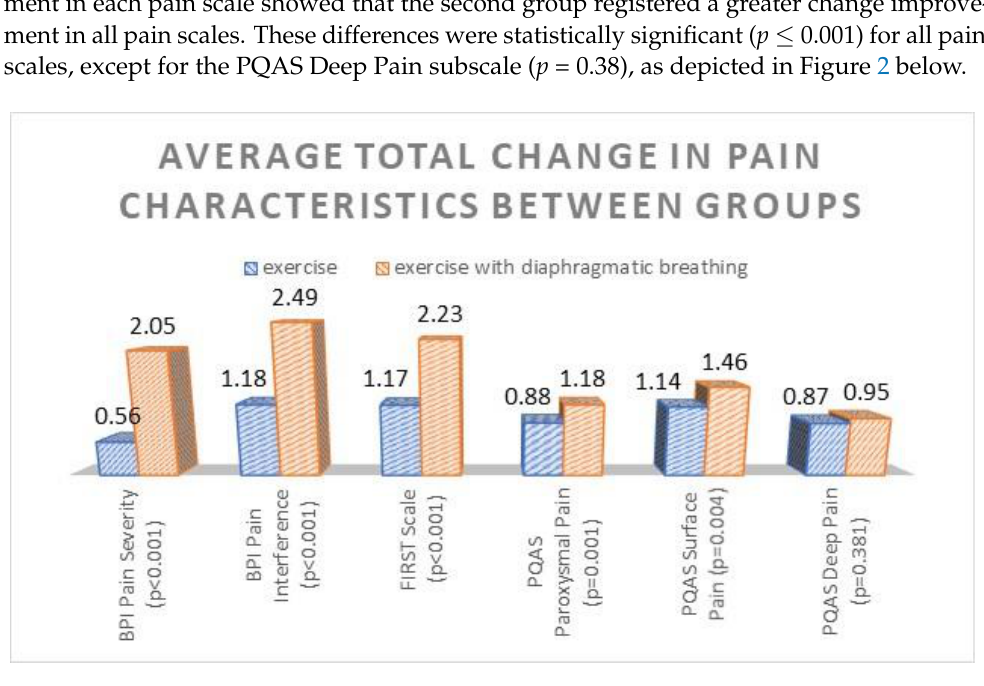
Figure 2. Average total change improvement in pain scales, estimated on marginal means for each group. p -values < 0.05 indicate statistically significant differences between groups.